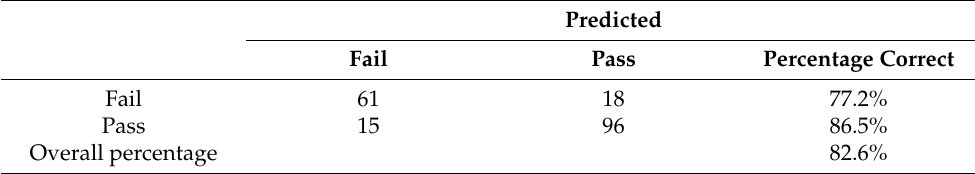
Table 4. Classification table for the